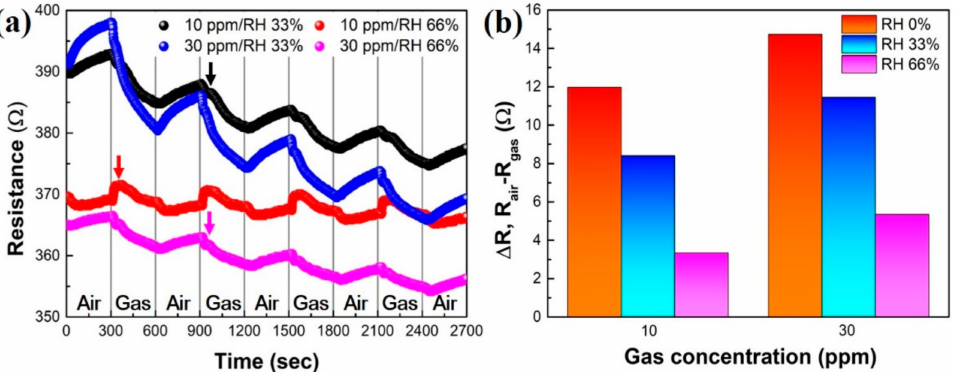
Figure 7. Humidity effect for GNWs/NiO-WO 3 /GNWs heterostructure-based gas sensor. ( a ) Re- sponse depends on humidity in NO 2 gas. ( b ) Tendency of resistance change based on ∆ R-versus- gas